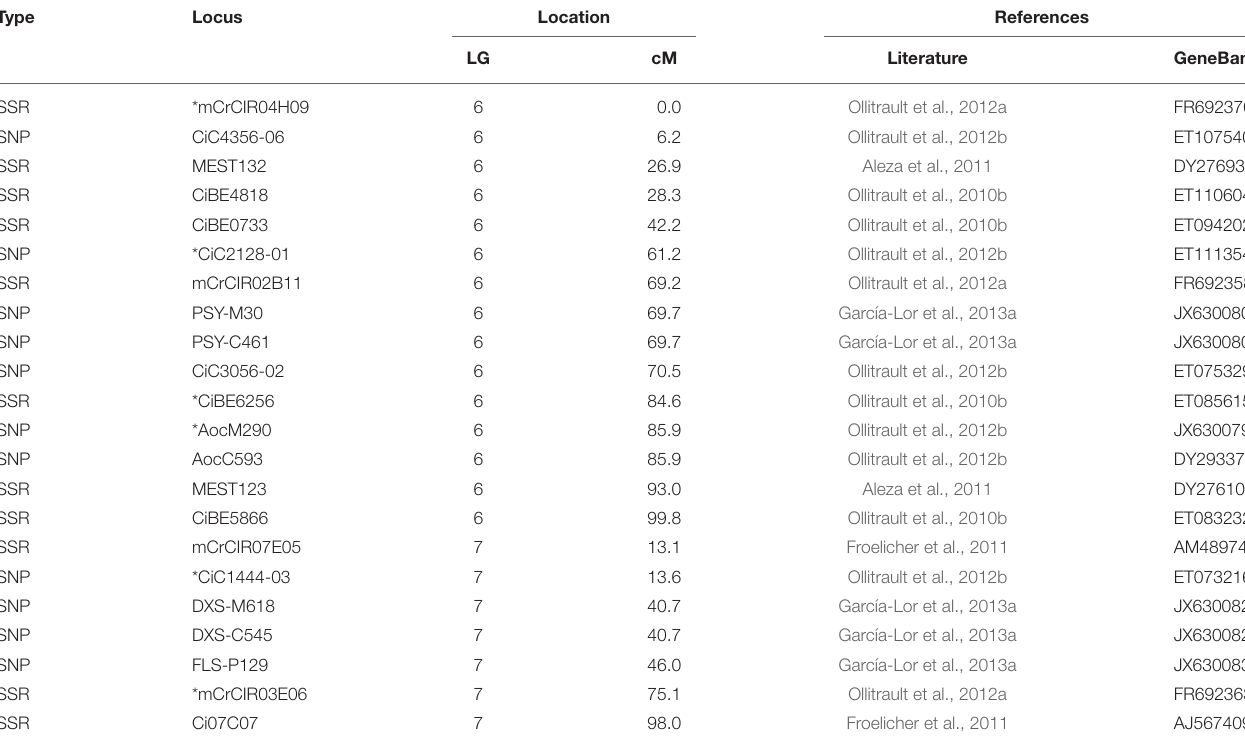
TABLE 3 | Molecular markers analyzed indicating the type of marker, locus name, linkage groups (LGs) 6 and 7 and location within LG in centimorgans (cM), bibliographic reference in the literature, and GeneBank